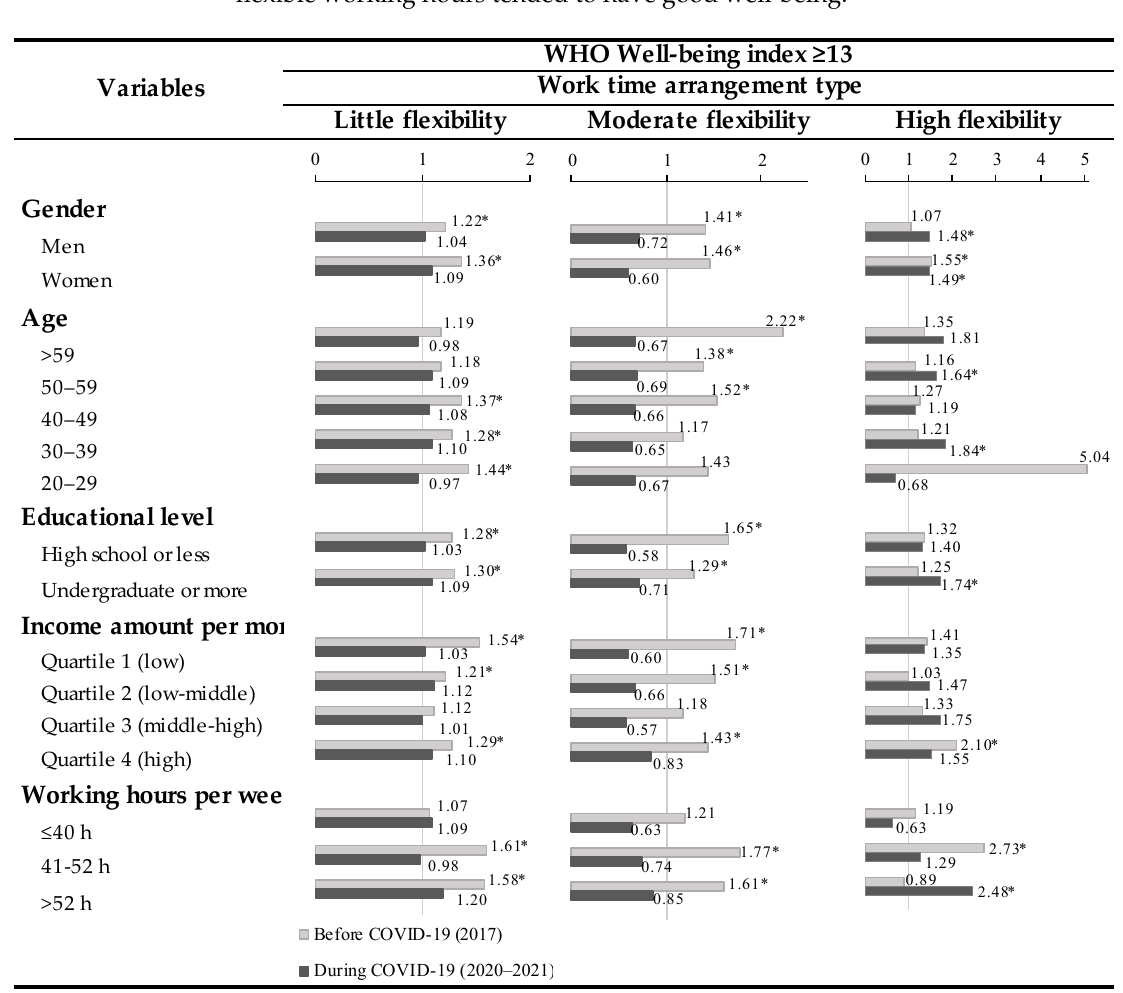
Figure 2. The results of sensitive analysis stratified by work time arrangement type and index of well-being.